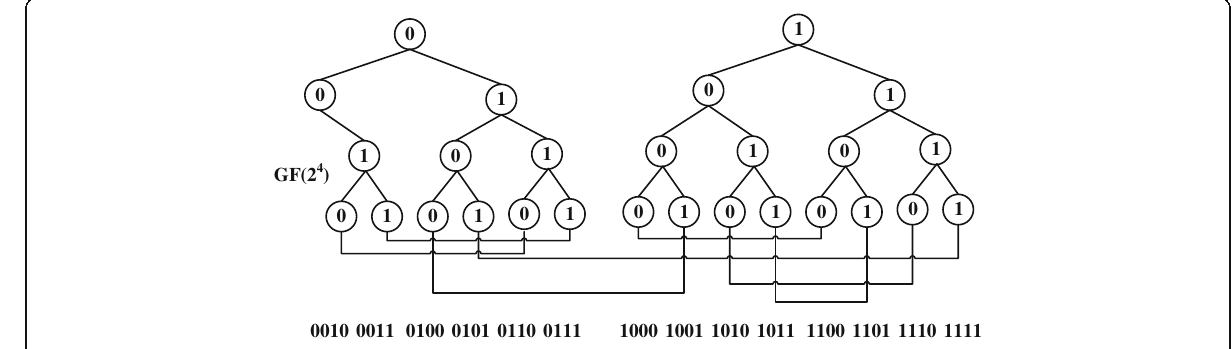
Fig. 3 Multiplicative inversion based on binary trees